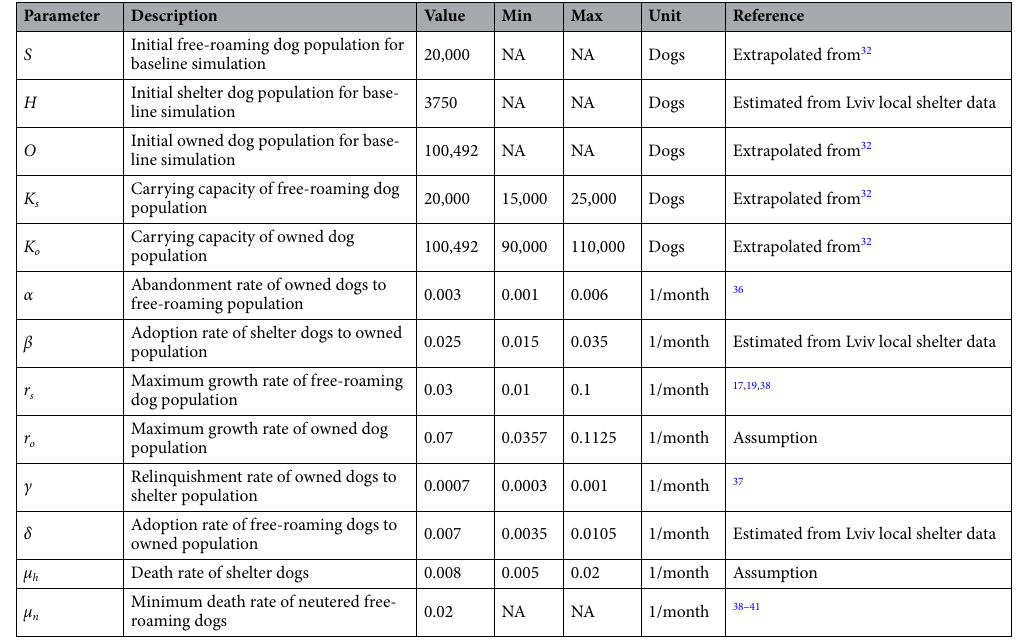
Table 1. Parameter description, parameter value, and minimum and maximum values used in the sensitivity analysis for the systems